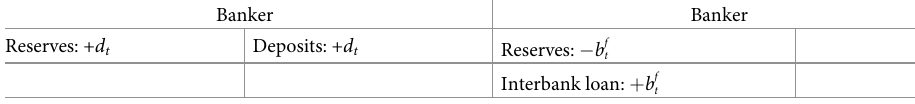
Table 4. Banker takes deposits (left) and makes interbank loan